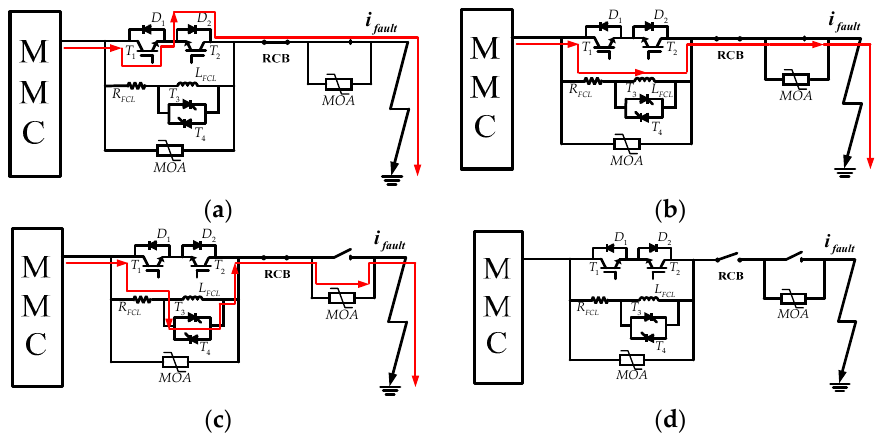
Figure 16. Sequence of fault interruption. ( a ) After fault occurrence and before fault detection, ( b ) T 1 and T 2 are switched o ff , ( c ) DCCB operates, T 3 and T 4 are turned on, ( d ) RCB opens, and T 3 and T 4 are turned o ff